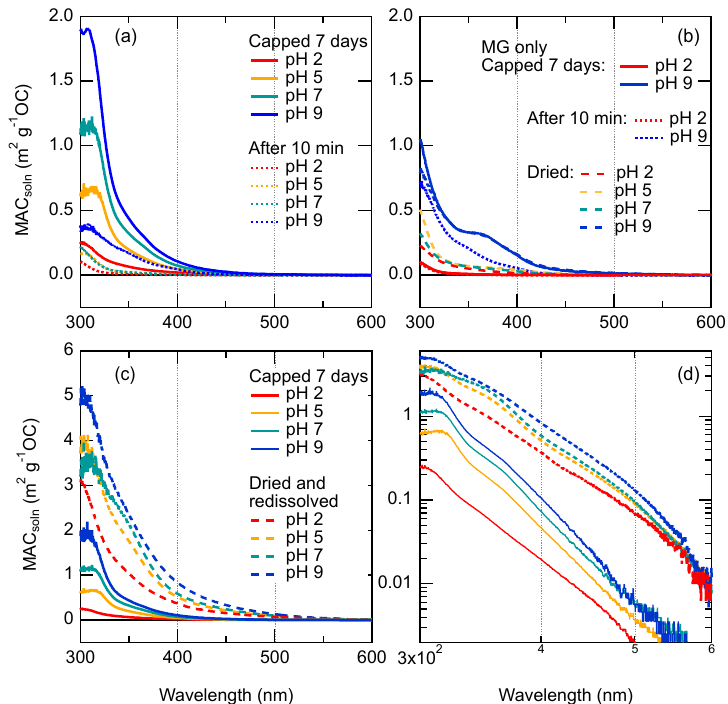
Figure 1. Normalized UV–visible absorbance spectra (displayed as mass absorption coefficient) for (a) methylglyoxal (1.0M) and ammo- nium sulfate (1.0M) reactions after 10min and after 7 days of reaction time, (b) control experiments without ammonium sulfate, (c) solu- tions in (a) after evaporation to dryness and (d) log-log plot of all spectra in (c) . Spectra have been baseline corrected using the measured absorbance between 650 and